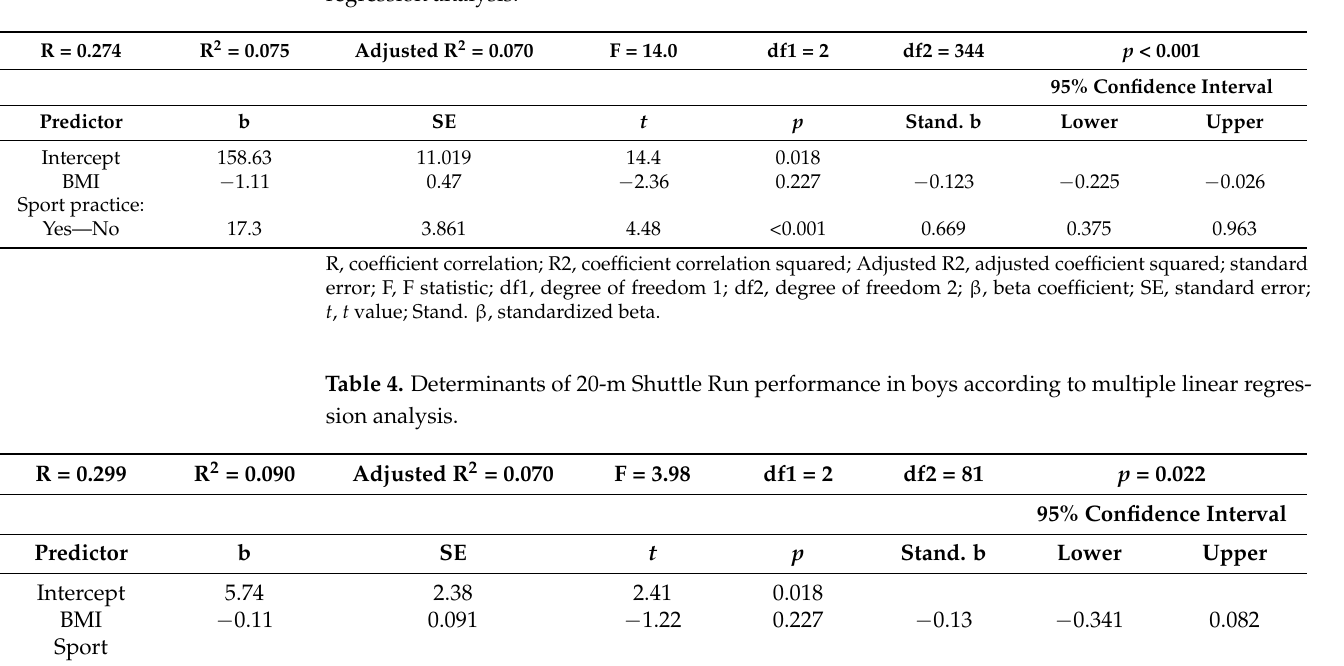
Table 3. Determinants of Standing Broad Jump performance in boys according to multiple linear regression analysis.